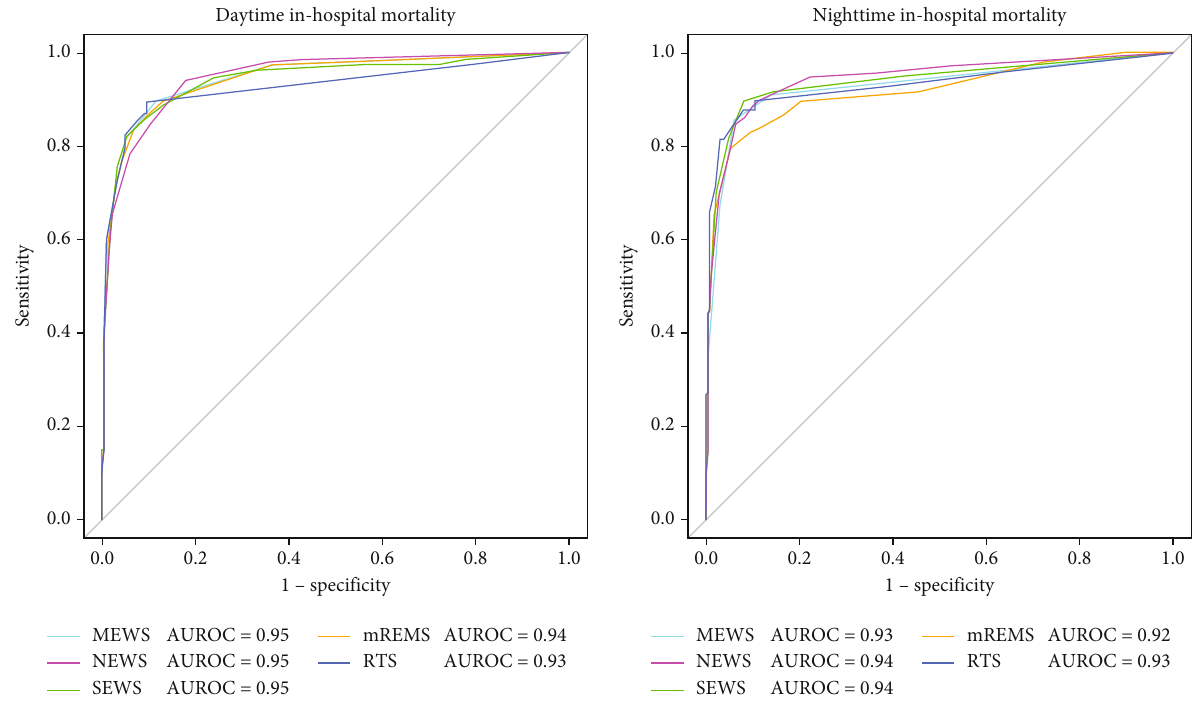
Figure 2: ROC curves for identifying in-hospital mortality among patients with multiple trauma admitted during the daytime and nighttime for fi ve triage scores. Table 4: Comparison of AUROCs, optimal cut-o ff s, sensitivity, and speci fi city for identifying in-hospital